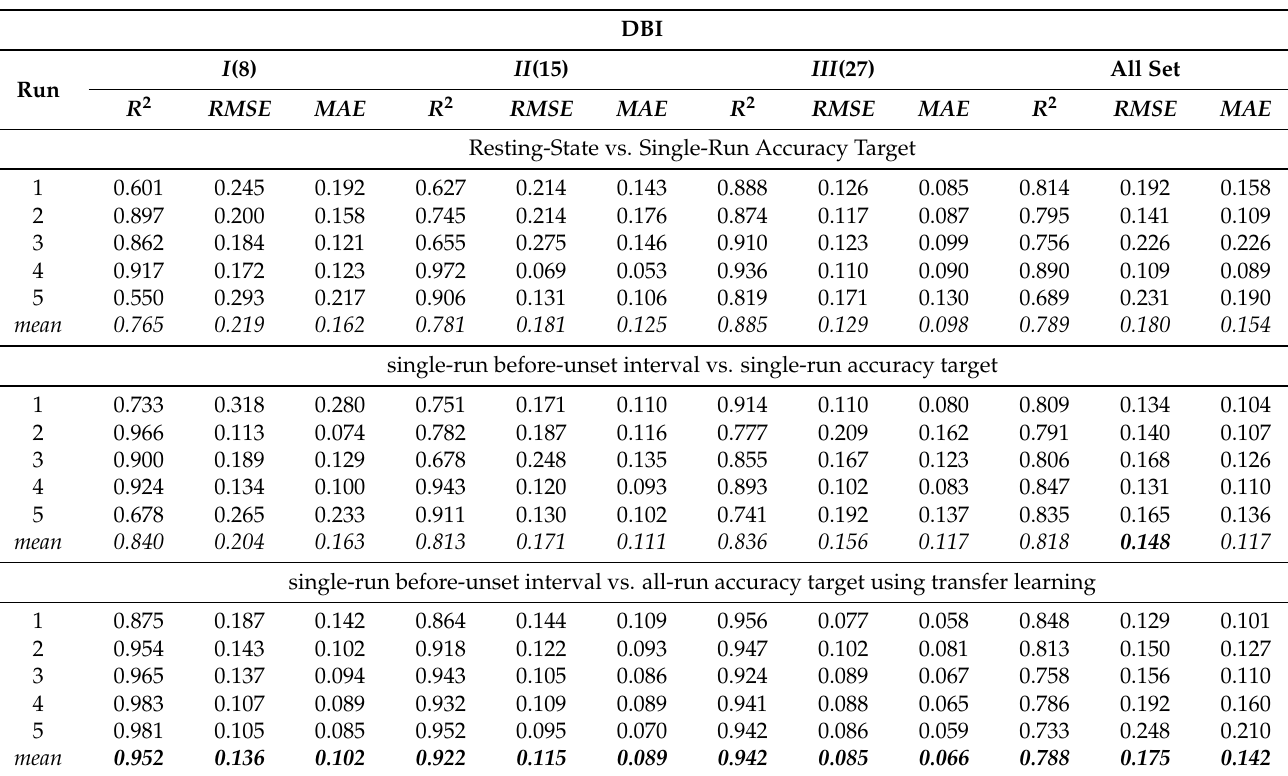
Table 6. DNR performance in predicting initial-training Synchronization, employing Monte Carlo dropout and the wide path configuration of all extracted rhythms ( θ + µ + β low ). The network regression is fed by the PLV predictor as the only single-trial FC